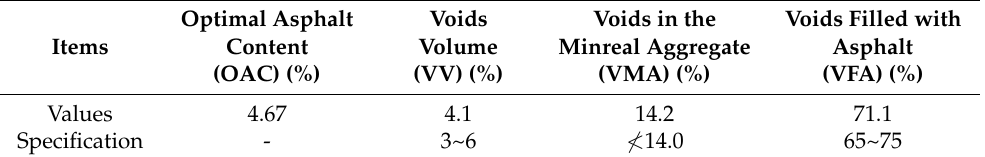
Table 4. Volume parameters of